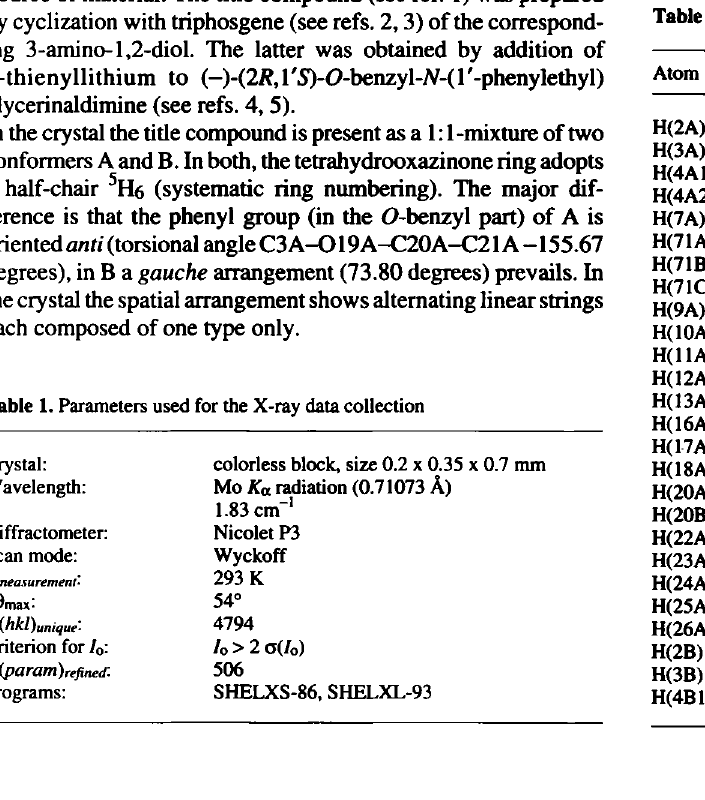
Table 2. Final atomic coordinates and displacement parameters (in Â 2